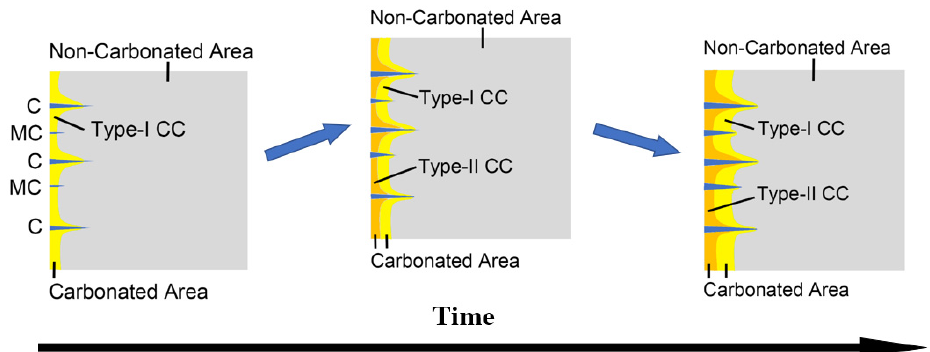
Figure 12. Full view of carbonation process for a cracked paste slice.